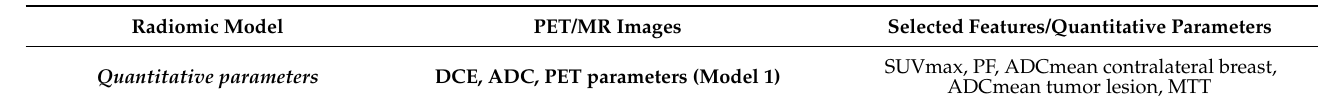
Table 1. Details of the developed radiomics model, including finally selected quantitative parame ‐ ters and/or radiomic features.